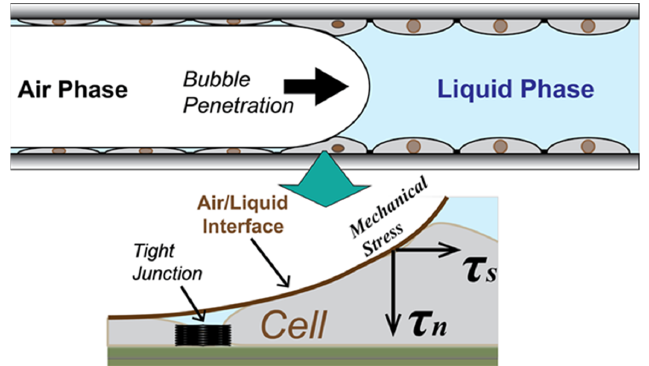
Figure 1. Schematic of stress on epithelial cell layer in the atelectrauma zone (not to scale). The re- cruitment and de-recruitment of air/liquid interface generate repetitive input of the mechanical stress on a membrane and tight junction of the wounded epithelial cell layer.